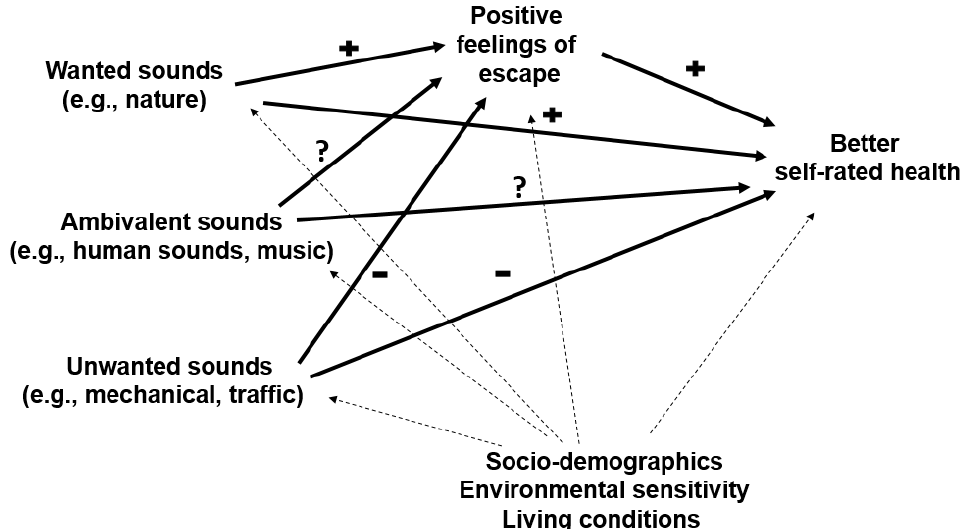
Figure 1. Conceptual framework showing hypothesized pathways between perceived sounds in the home and self-rated health during home confinement. Note: Dashed lines represent hypothesized confounding or modifying effects of contextual factors.